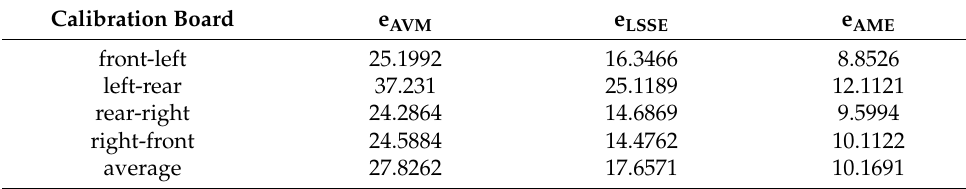
Table 3. AVM errors of the proposed method.